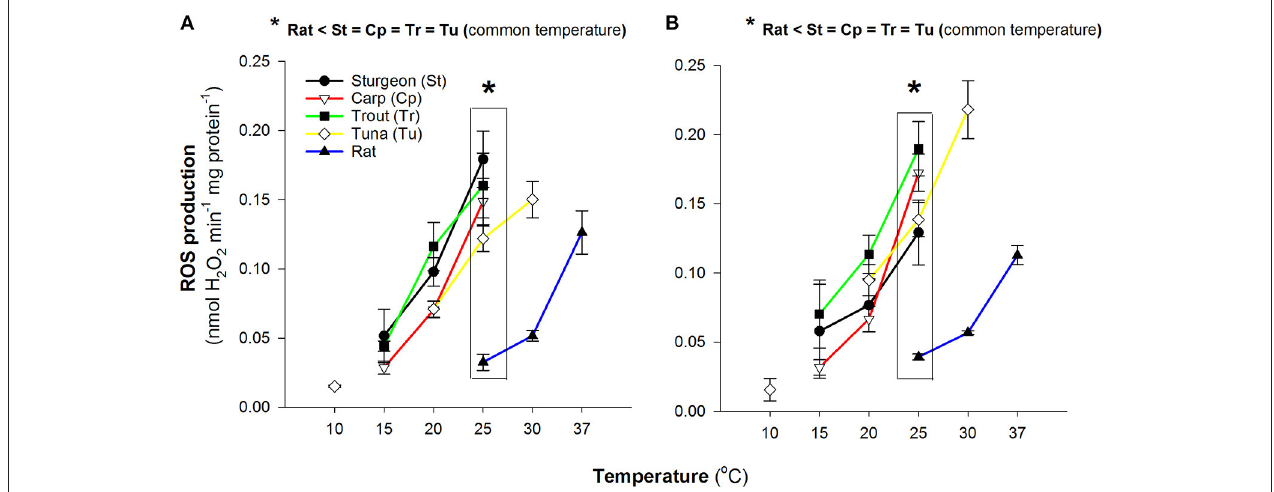
FIGURE 1 | Comparison of reactive oxygen species production by isolated muscle mitochondria. Data are mean ± SEM ( n = 3–5 depending on species) and substrates were 5 mM pyruvate and malate (A) or 0.05 mM D/L-palmitoylcarnitine and 5 mM malate (B) . Assay temperature is indicated and rates were determined as H 2 O 2 efflux normalized to mitochondrial protein. Physiologically relevant temperatures are 15 ◦ C for sturgeon, carp and trout; 25 ◦ C for Bluefin tuna; 37 ◦ C for rat.